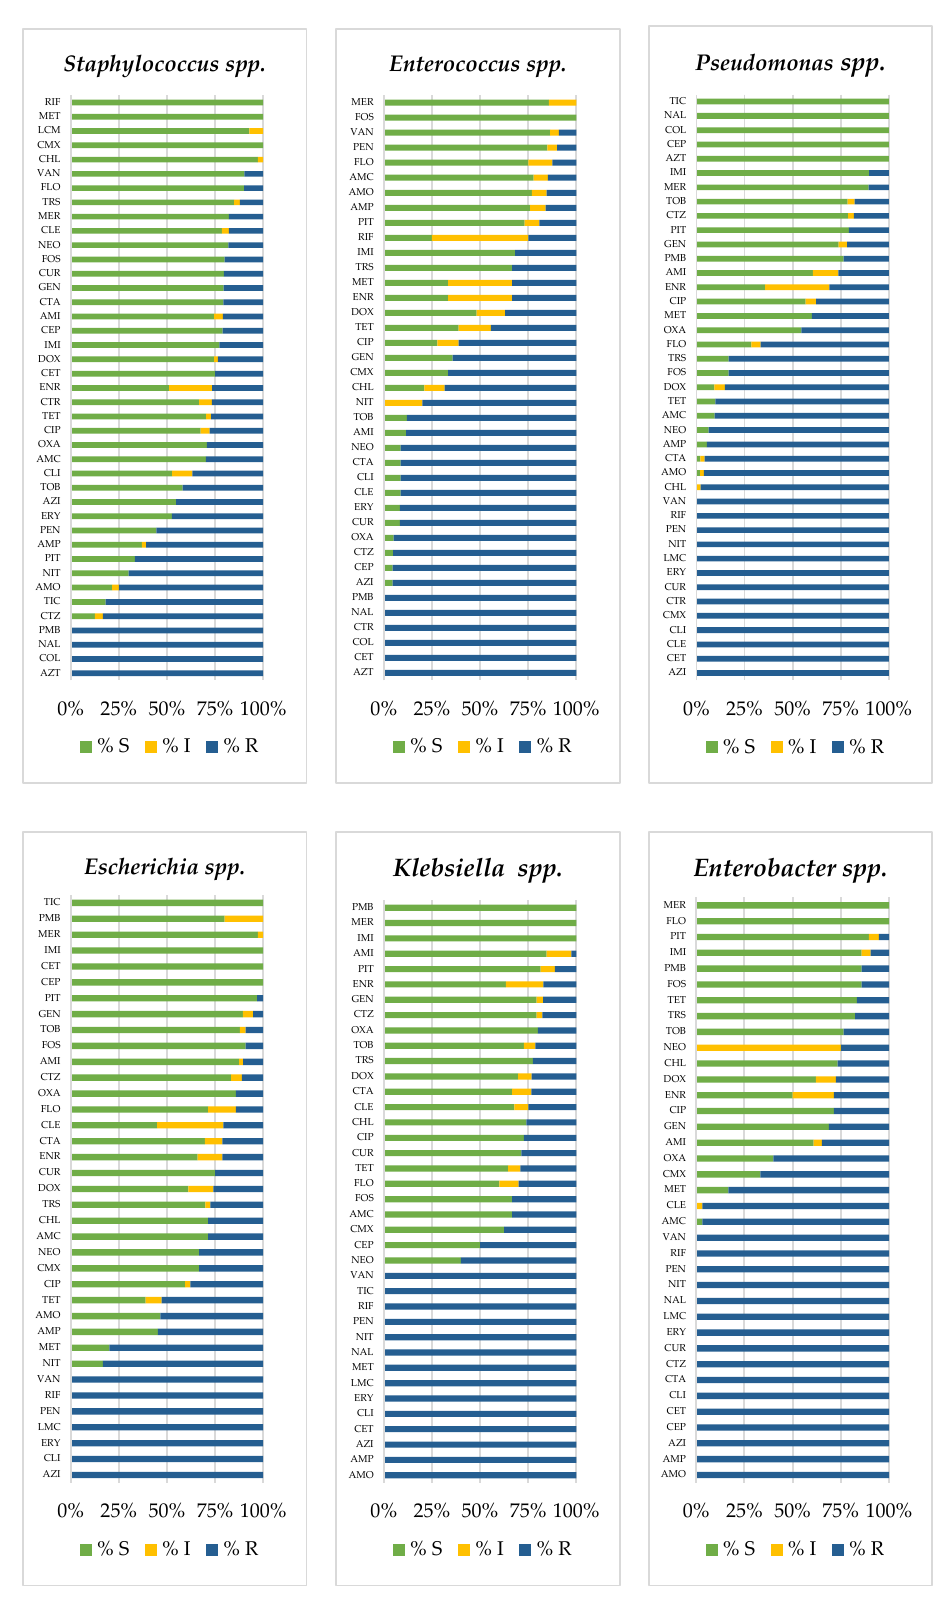
Figure A2. Proportion of susceptible (S), susceptible—increased exposure (I), and resistance (R) bacterial strains in bird class.